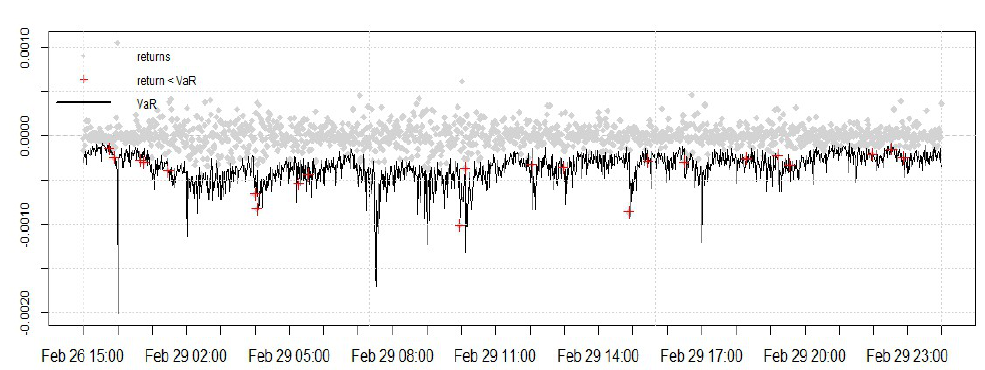
Figure 7. Sigma forecast plot.